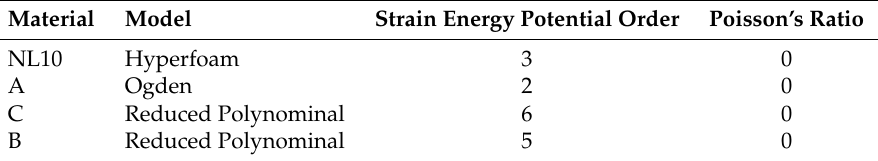
Figure 5. Numerical model to simulate the dynamic tests. Table 6. Constitutive parameters for dynamic numerical tests.